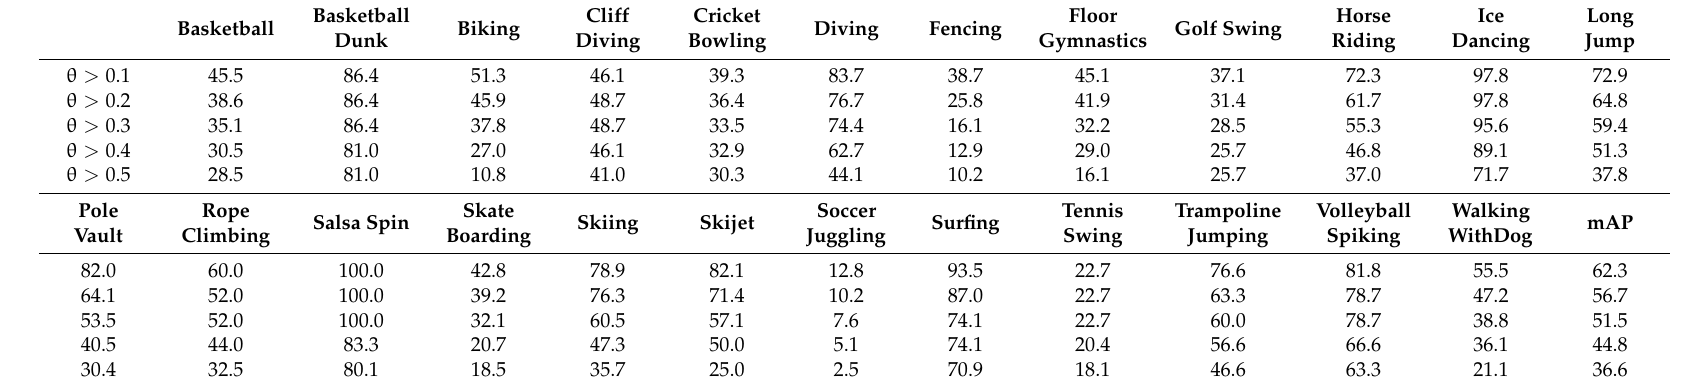
Table 6. Comparison between action-detection performances of tIoU and UCF-101